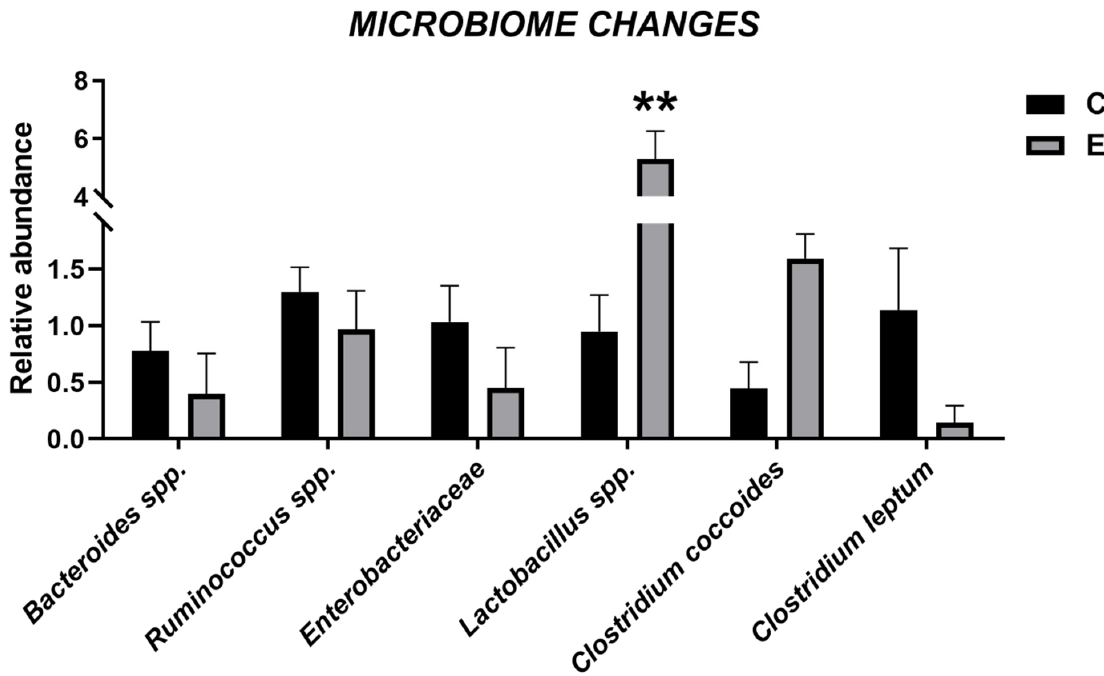
Figure 5. Microbiome changes induced by flaxseed meal administration in broilers ( n = 10) determined by qRT-PCR using primers for 16S rDNA. Statistical significance is indicated as ** p ≤ 0.01. primers for 16S rDNA. Statistical significance is indicated as ** p ≤